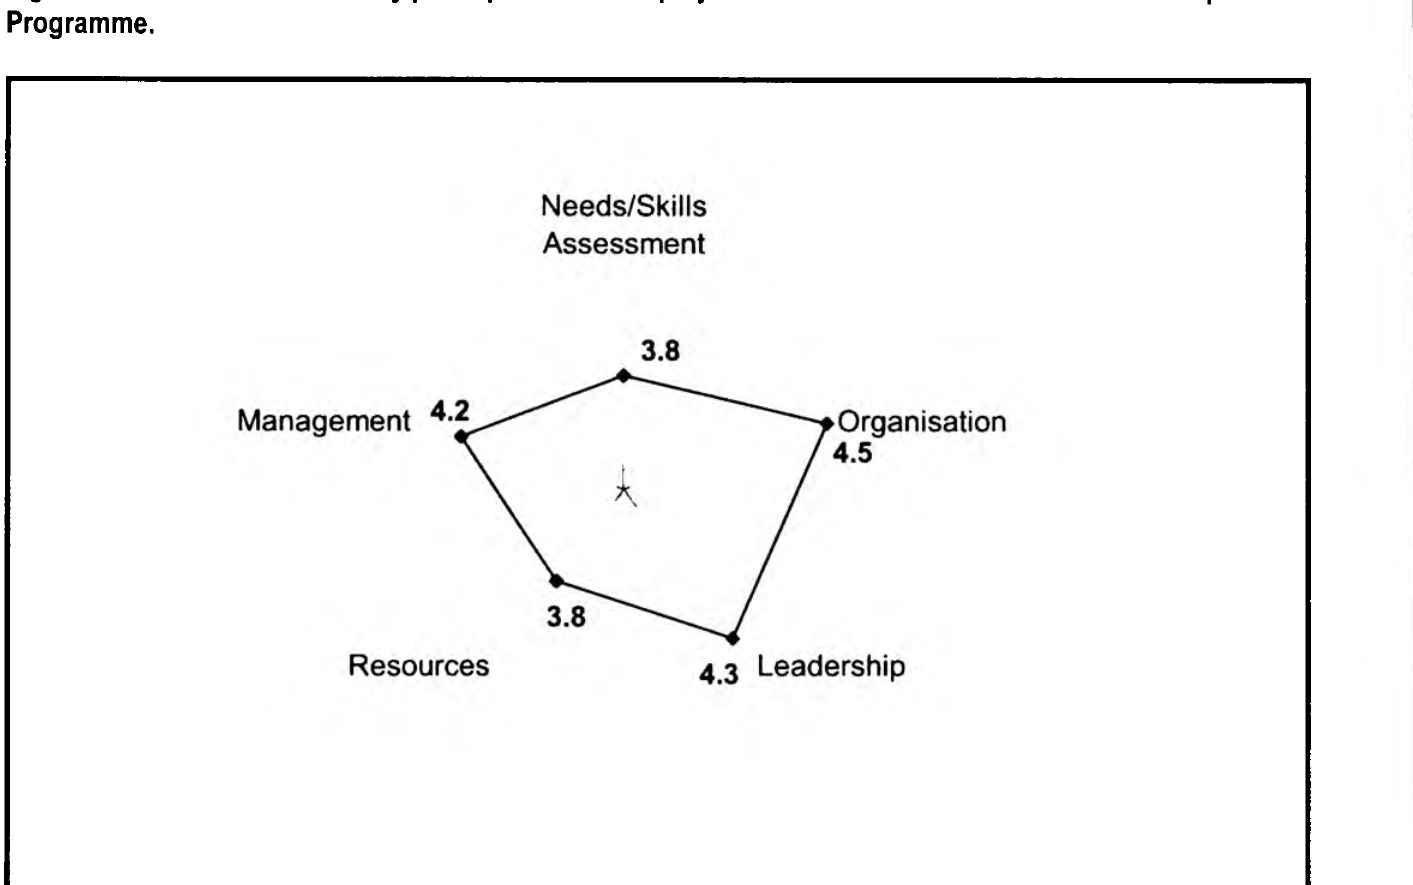
Figure 2. The level of community participation in PHC projects in the Muldersdrift Health and Development